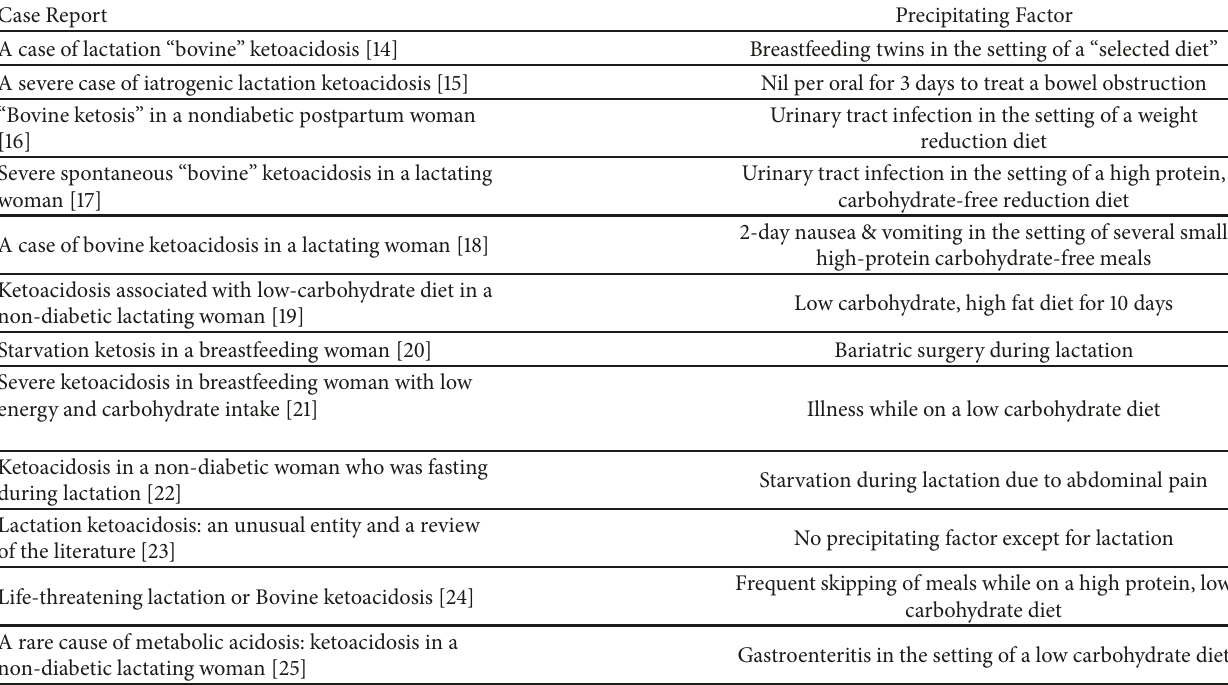
Table 1: Literature review of existing case reports and their precipitating factor.